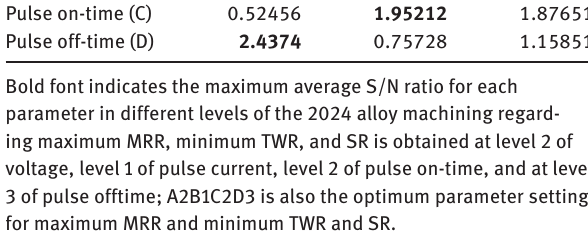
Table 18: The average MSNR for each input parameter in different levels in the machining of Al/5%Al